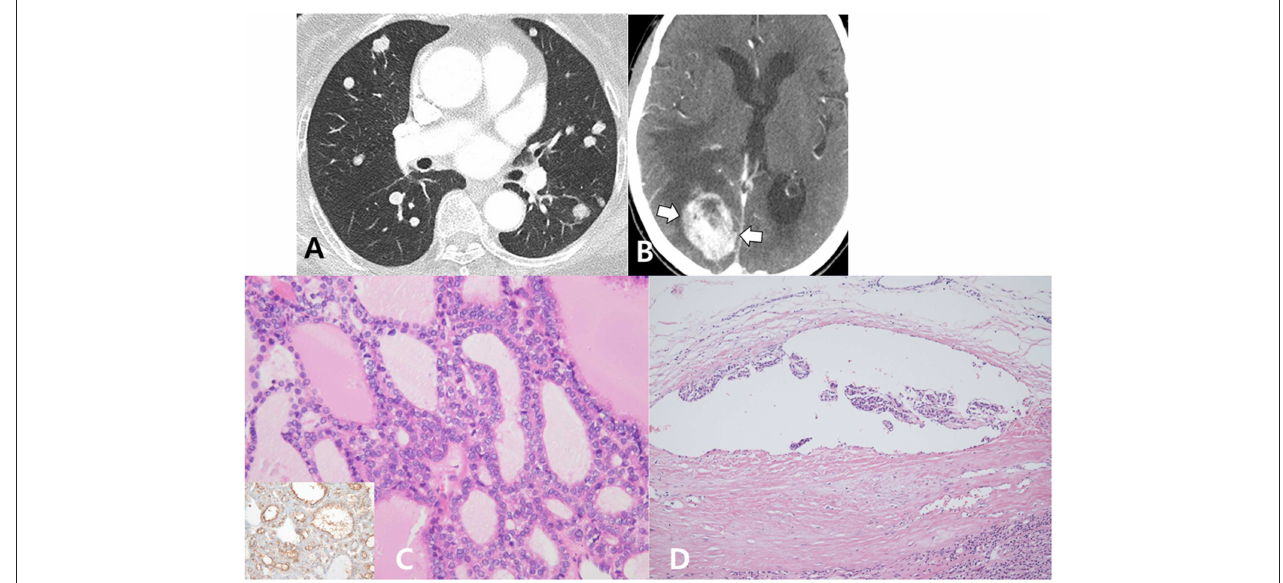
FIGURE 3 | Multiple metastatic nodules in both the lungs exhibited interval increase in size and number on follow-up chest CT (A) . On the same day, the patient underwent neck CT, and a newly developed heterogeneous enhancing mass (arrows) was detected in the right parietal lobe (B) . In the re-evaluation of a previous right lobectomy specimen, the right thyroid mass was entirely composed of small- and large-sized follicles and diffusely presented with papillary-like nuclear features (hematoxylin and eosin stain, × 400), which were positive for HBME-1 immunohistochemical staining (inset) (C) . A focus of discrete vascular invasion with endothelium covered tumor cells adherent to the vessel wall (hematoxylin and eosin stain, × 200) is identified (D) .